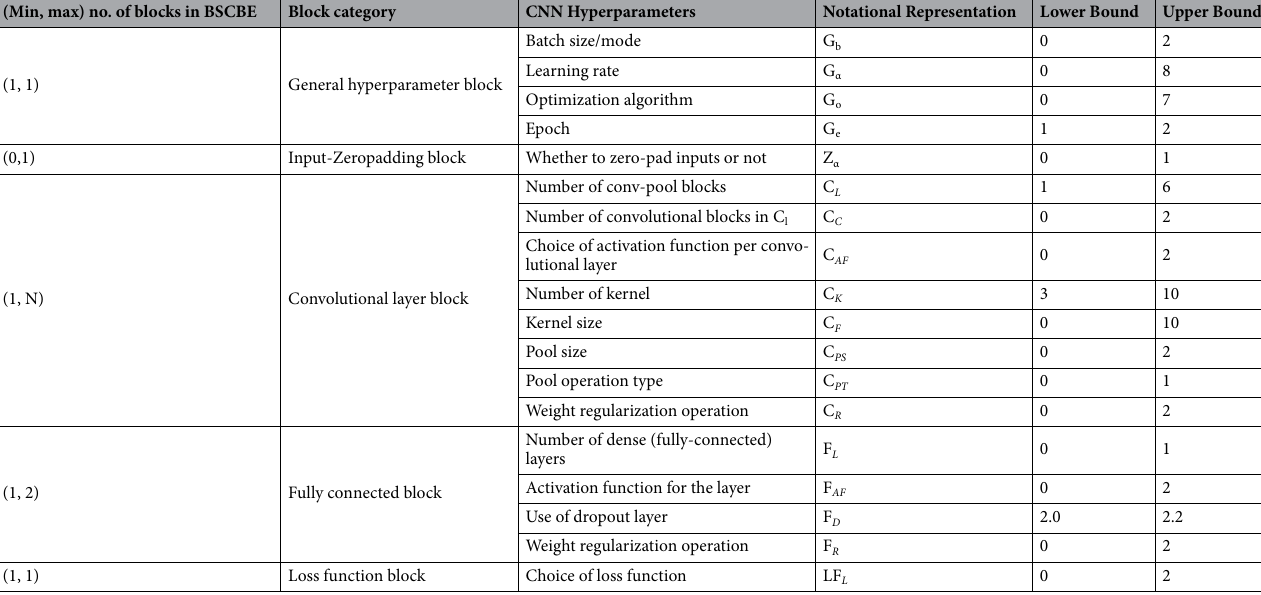
Table 3. Categorization of parameters based on the block encoding scheme for representation of the hyperparameters of convolutional neural